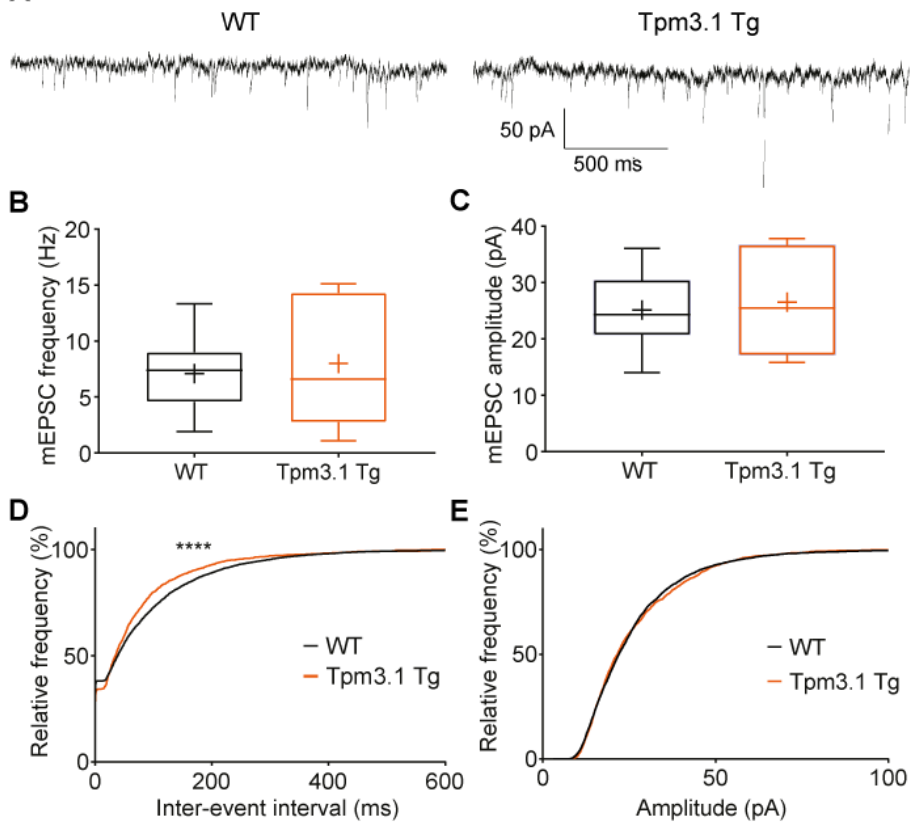
Figure 5. The effect of Tpm3.1 overexpression on mEPSC properties in cultured dissociated hippocampal neurons compared to WT. ( A ) Representative recording traces collected from WT and Tpm3.1 Tg cells. ( B ) Mean mEPSC frequency and ( C ) amplitude. ( D , E ) Cumulative probability histograms of mEPSC inter-event interval and amplitude; 200 events sampled from each cell. WT n = 21 cells, Tpm3.1 Tg n = 8 cells, from 4 separate culture preparations. WT values are shown in black, Tpm3.1 Tg values shown in orange. **** indicates p < 0.0001. There were also no differences in the mEPSC rise time (WT: 0.82 ± 0.05 ms; Tg: 0.69 ± 0.04 ms; Mann–Whitney test p = 0.2) or decay (WT: 4.8 ± 0.470 ms; Tg: 4.0 ± 0.29 ms; Mann–Whitney test p =